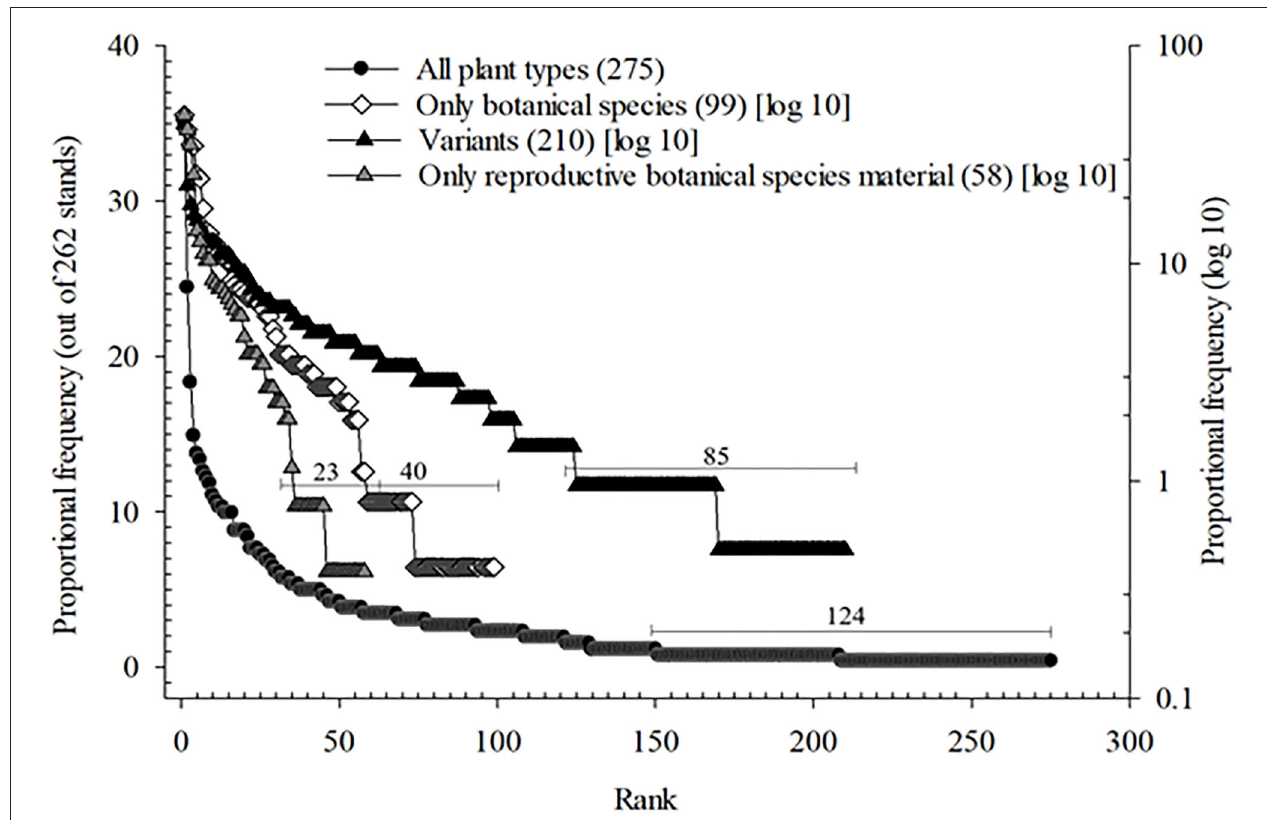
FIGURE 6 | Proportional rank-frequency curve of different richness parameters of the food plants from local merchants in 10 markets in the Huasteca Potosina.